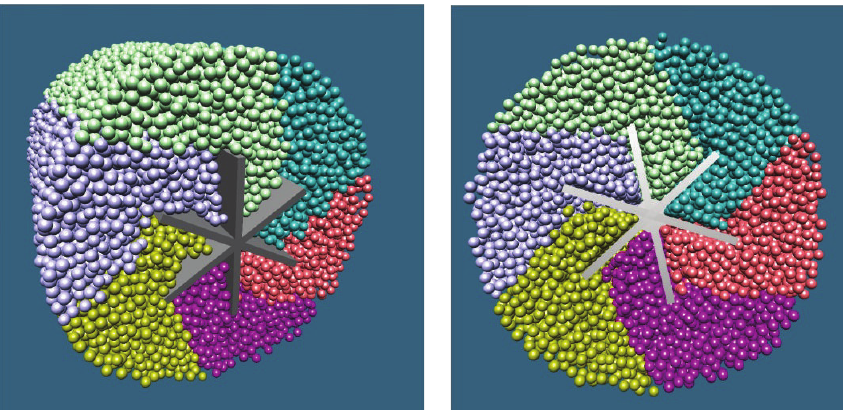
Figure 4: Simulation of a vane rotating in granular material using the SPH based approach (here, the flow of suspended spherical particles in a non-Newtonian fluid matrix is modeled. Simulations were carried out using resources of the Argonne Leadership Computing Facility at Argonne National Laboratory. (Image was created with the assistance of William George and Stephen Satterfield of NIST)).